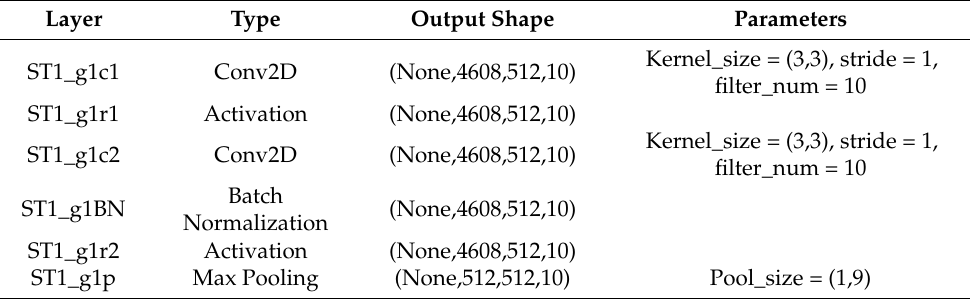
Table 1. The first block structure in ST1 stream.